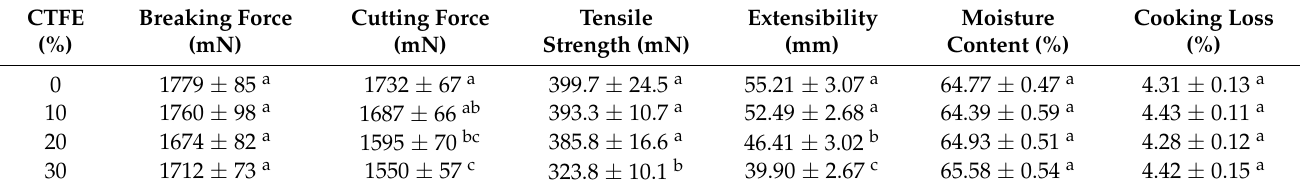
Table 2. Influence of CTFE amount on texture and cooking properties of